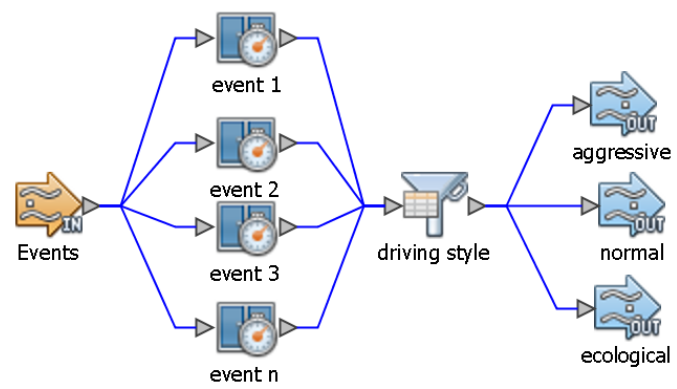
Figure 2. An example of the definition of a chronicle using the IEP component in OpenESB.